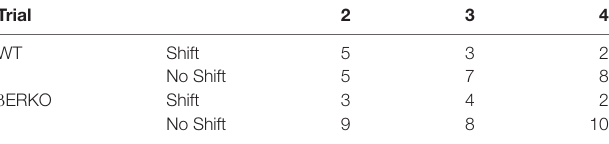
TABLE 1 | Number of pairs with winner shift in each